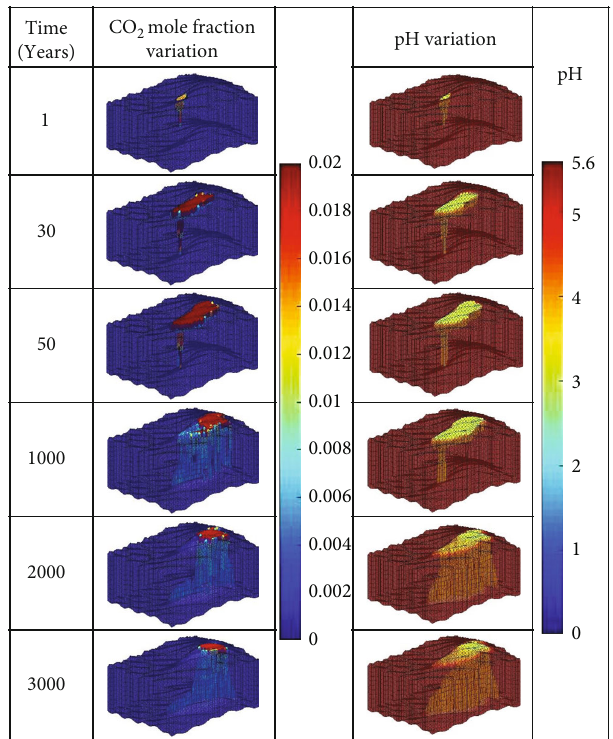
geological sequestration and their evolution over geological time scale. 2